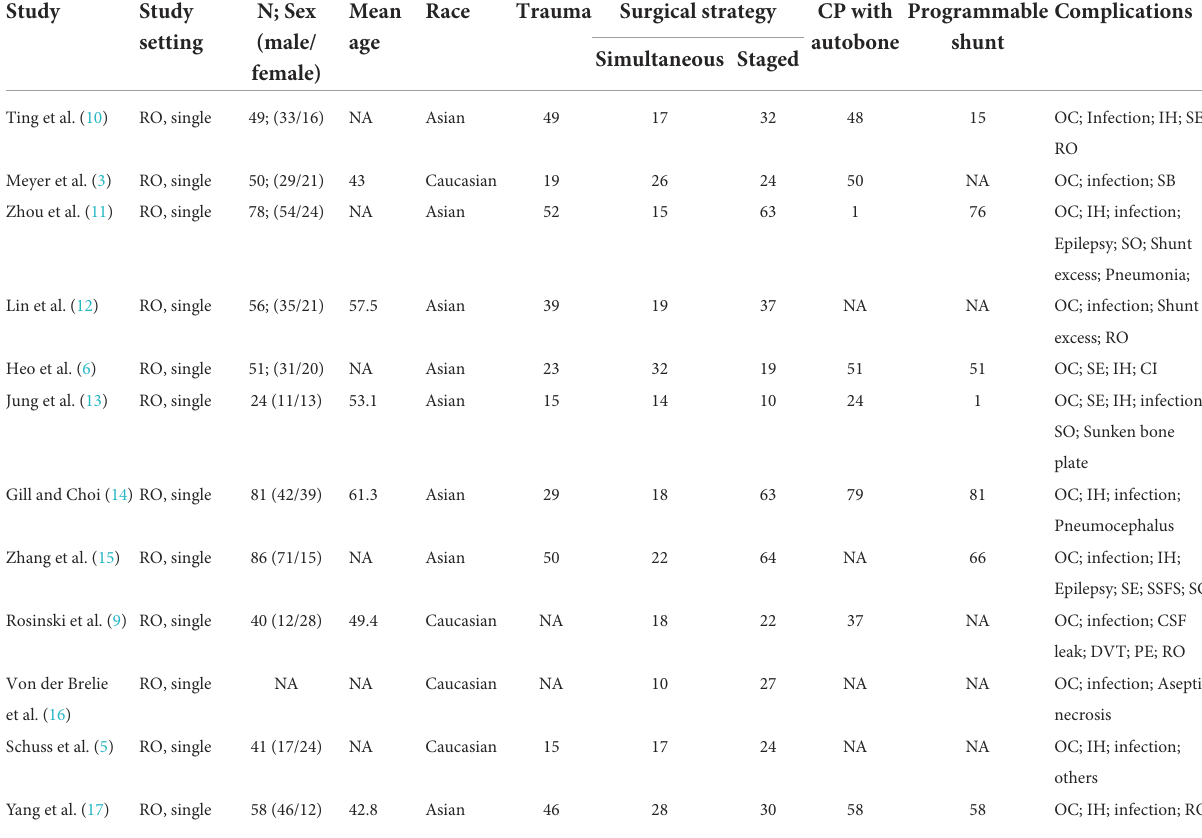
TABLE 1 Baseline characteristics for studies included in the meta-analysis.